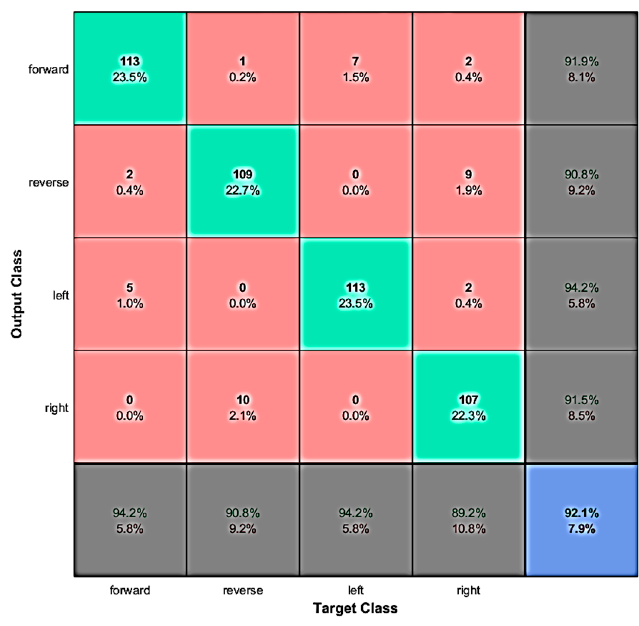
Figure 9. Confusion matrix for all issued subject commands.